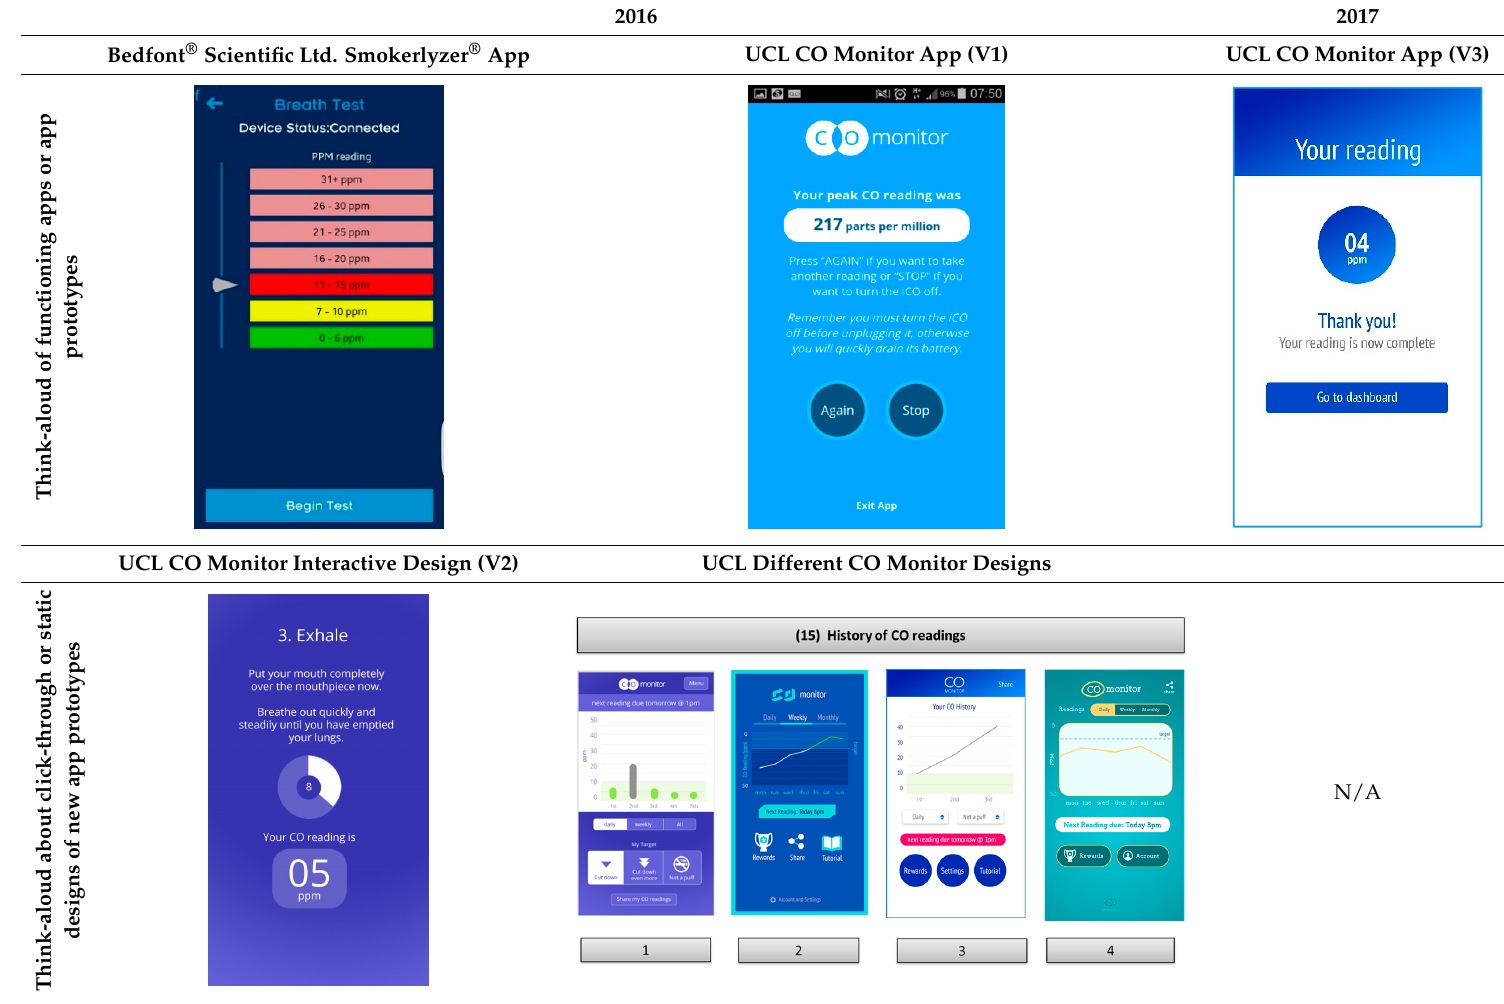
Table A2. Interview prompts (example screenshots presented) of existing and prototype apps and designs to work with personal CO monitors.